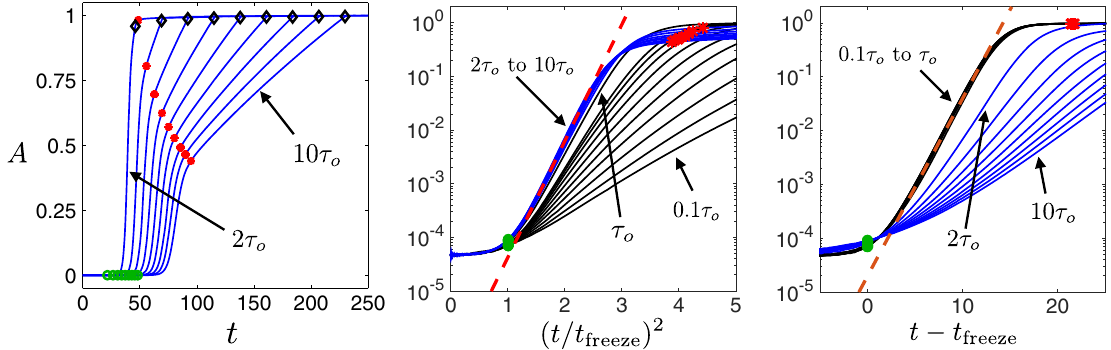
FIG. 1. Left: The normalized average condensate A ð t Þ defined in (3.9) for quench rates τ 161 . 37 =T with τ . The black diamonds denote the times at which for each τ o ¼ c period of rapid growth, which is followed by a period of approximate linear growth. The start of the rapid growth can be identified as t , which we operationally define as the time at which A ð t Þ ¼ 2 A ð −∞ Þ , and are denoted by the green circles. The crossover from freeze exponential to linear growth corresponds to the equilibration time t A 00 ð t < 0 . 1 max f A 00 ð t Þg , and are labeled by the red stars and circles. Middle: Scaling behavior of slow quenches; when A is plotted vs eq Þ ¯ t 2 ¼ ð t=t 2 , only curves corresponding to slow quenches collapse into a single one. The linear behavior in the logarithmic plot is freeze Þ consistent with (3.2). Right: Scaling behavior of rapid quenches; A ð t Þ is plotted vs t − t τ n τ for n ¼ 0 . 1 ; 0 . 2 ; … ; 10 . As predicted from (3.6), only τ Q ¼ o which exhibits linear exponential growth. All dimensional quantities are measured in units of T